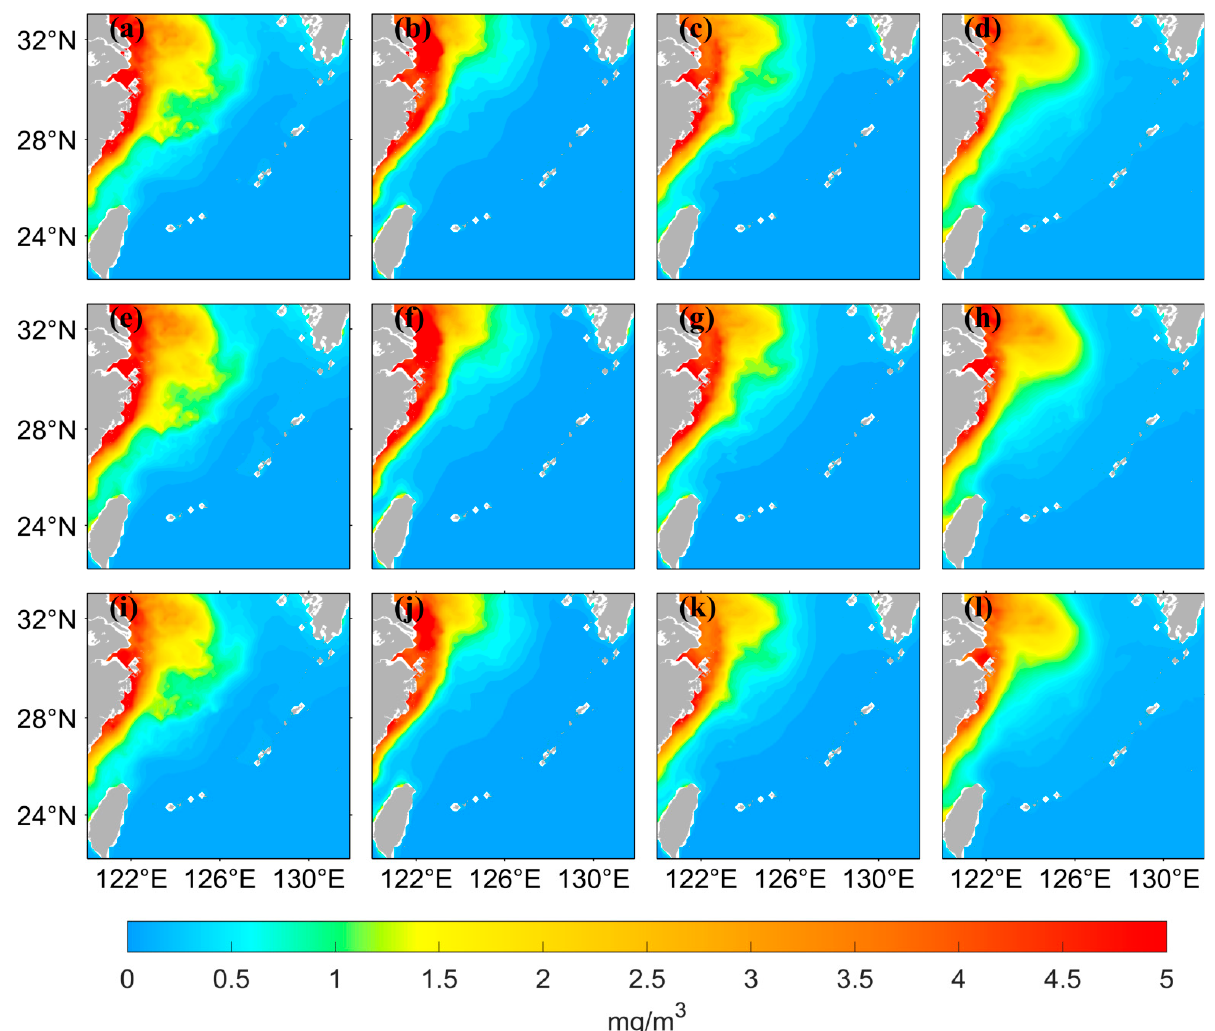
Figure 6. Spatial distribution of satellite-observed values and predicted values from LSTM models using two different data processing methods for four seasons. March to May represents Spring, June to August represents Summer, September to November represents Autumn, and December to February represents Winter. ( a – d ) represent the distribution of the data from satellite observations, in the order of spring, summer, autumn, and winter. ( e – h ) represent the distribution of the values predicted by the LSTM model using the original values as input, and ( i – l ) represent the distribution of the values predicted by the LSTM model using the logarithmic values as input.